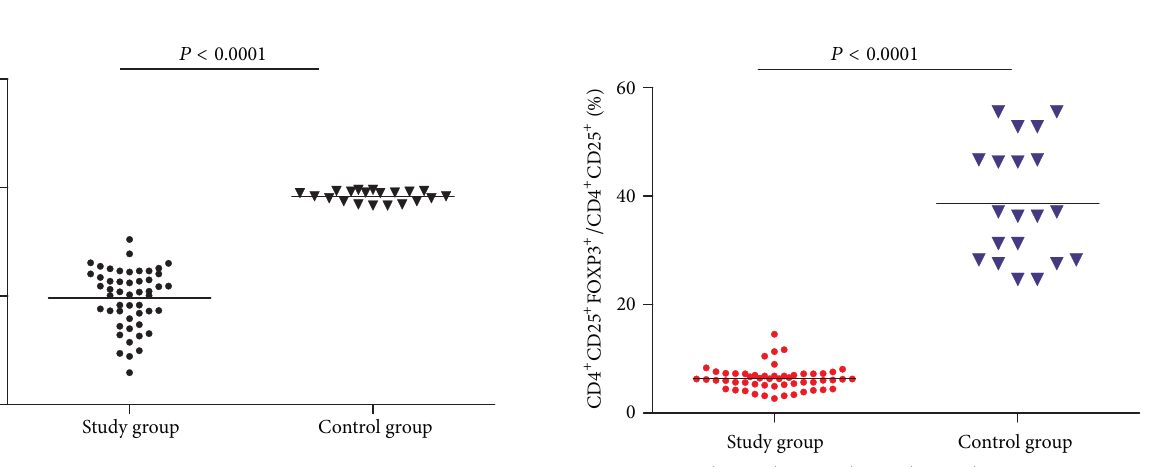
Figure 5: FOXP3% in study and control group. Figure 6: CD4